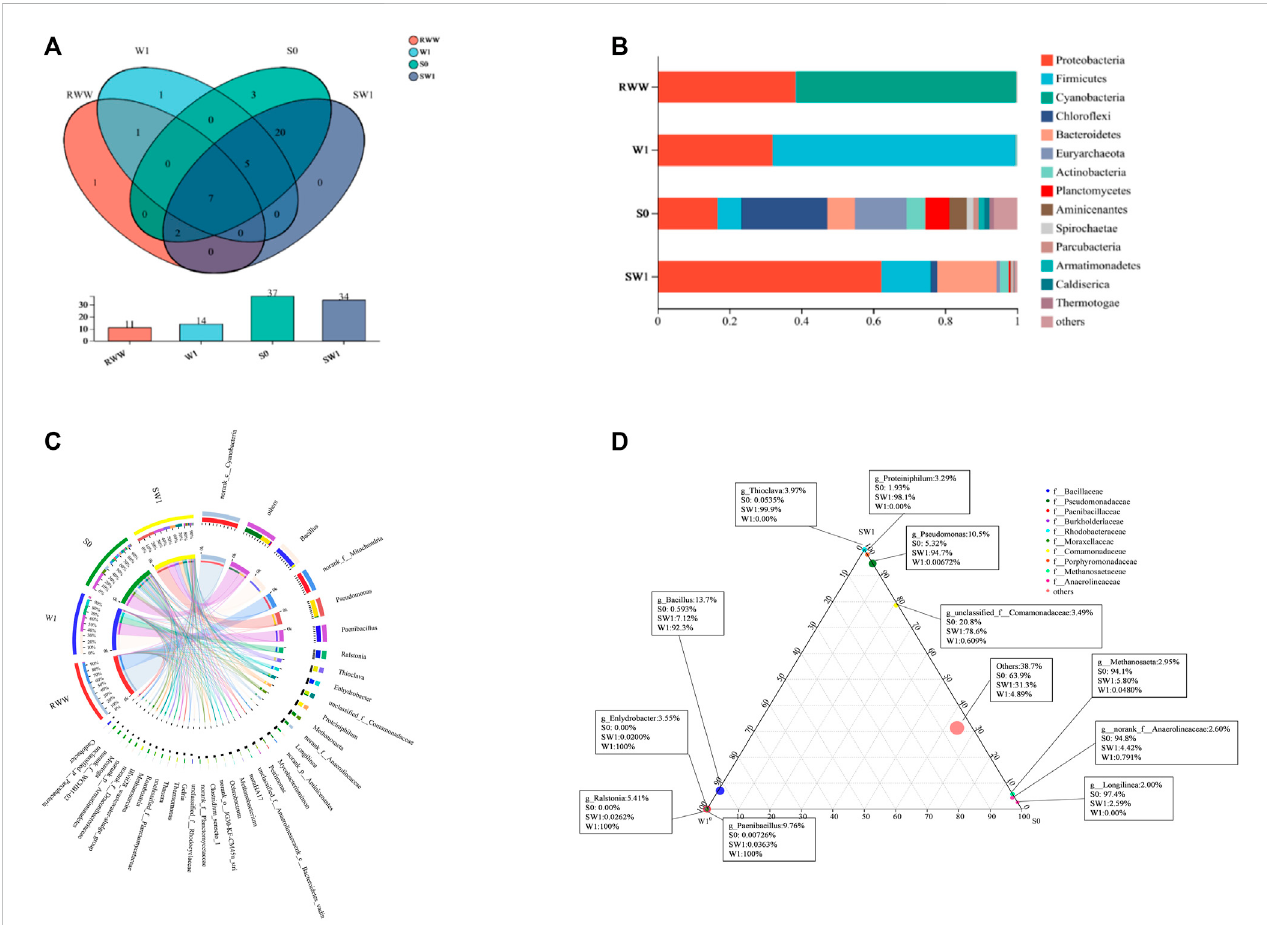
FIGURE 3 Venn diagram of samples (A) and percentage of community abundance (B) on the phylum level. Circos diagram (C) and ternary analysis (D) of microbial communities on the genus